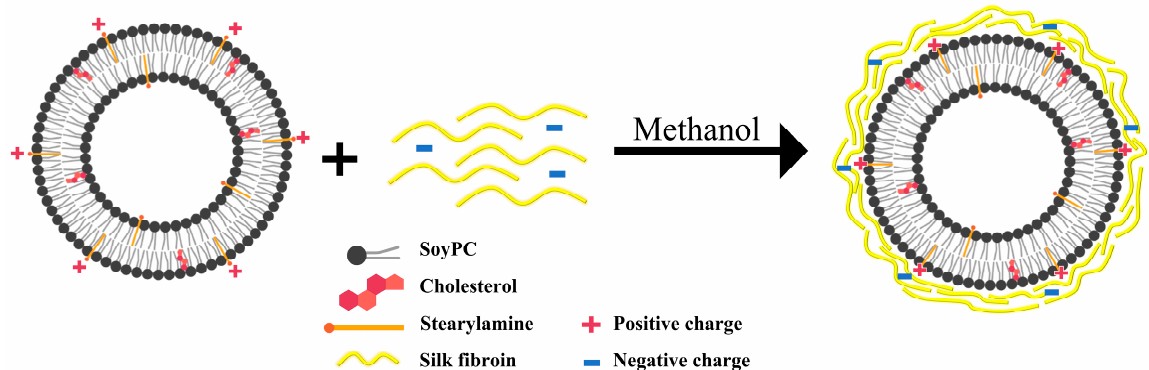
Figure 1. Schematic representation of liposomes containing soy phosphatidylcholine (soy PC), cholesterol (CH), and cationic stearylamine (SA) coated with SF via electrostatic interaction.